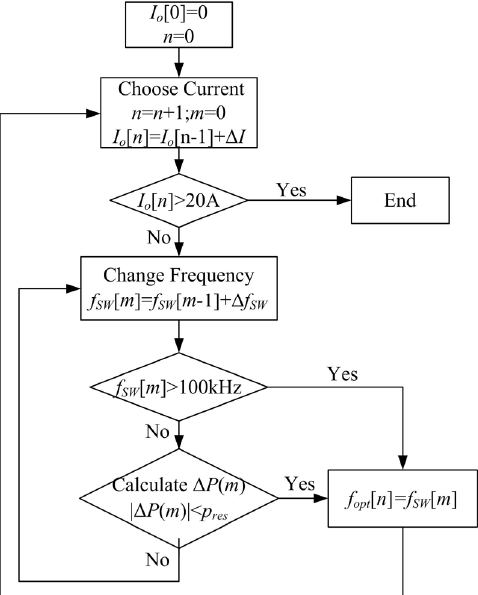
Figure 14. Block diagram of the switching frequency optimization procedure.